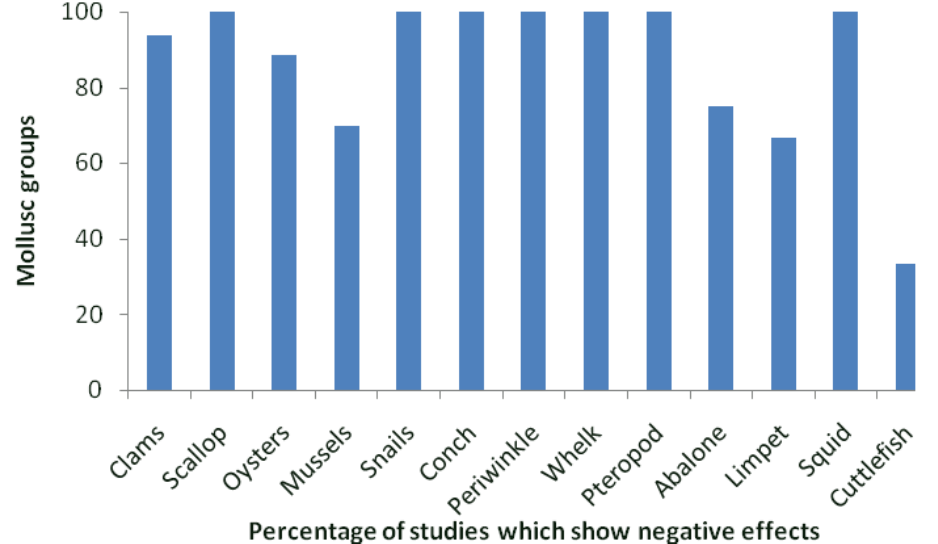
Figure 2. Percentage of studies which show negative effects of ocean acidification on one or more processes for each mollusc